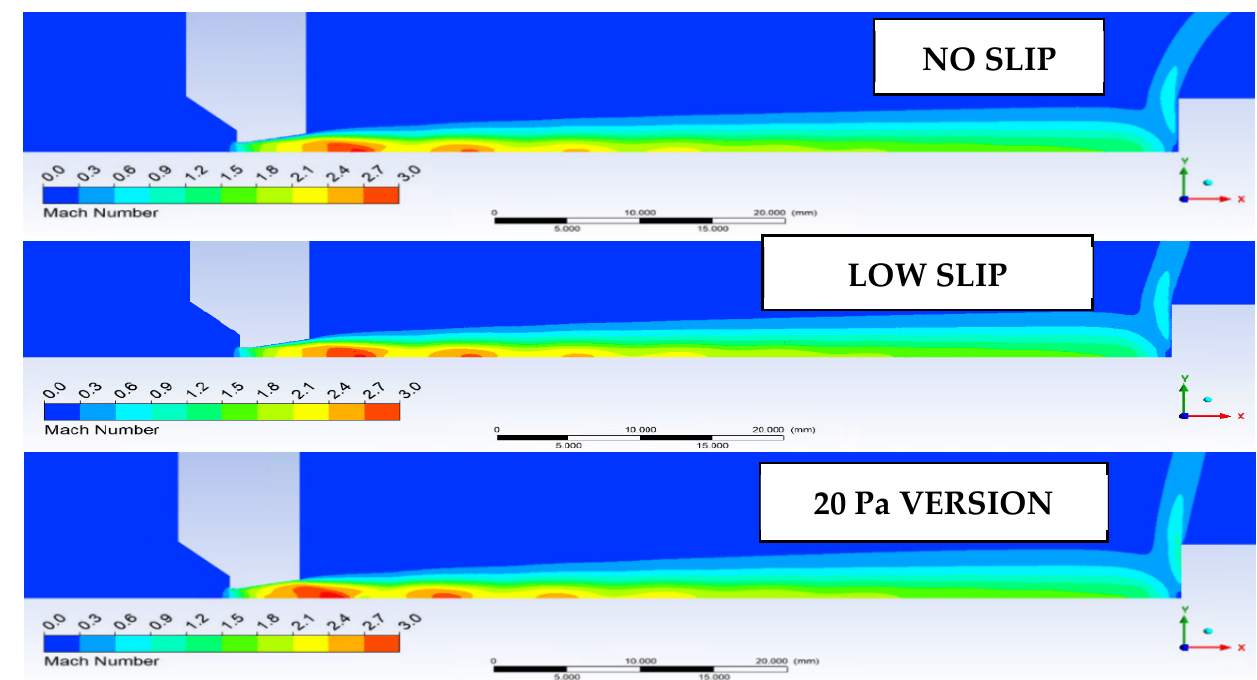
Figure 20. Distribution of Mach disks for the investigated variants.